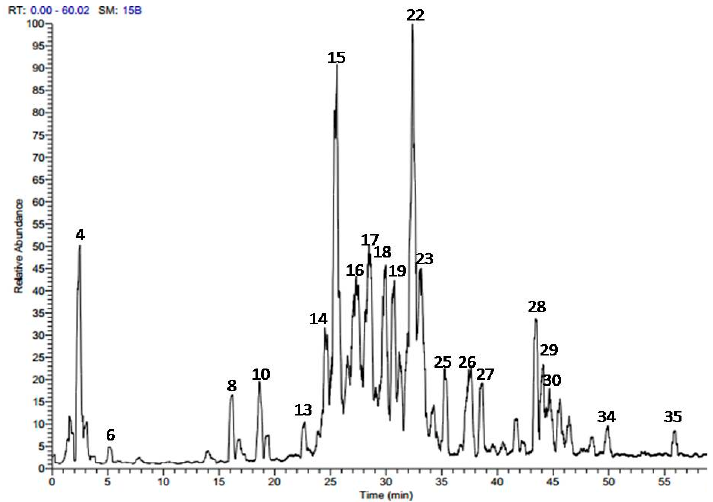
Figure 1. Total ion chromatogram of the methanol extract of A. harveyi leaves [LC-MS-ESI ( − )].